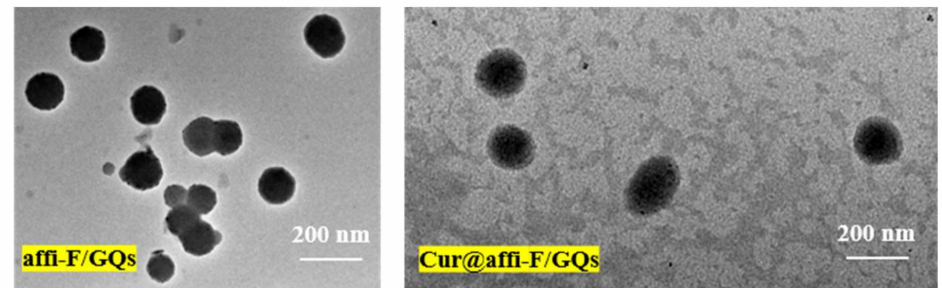
Figure A5. TEM images of affi-F/GQs and